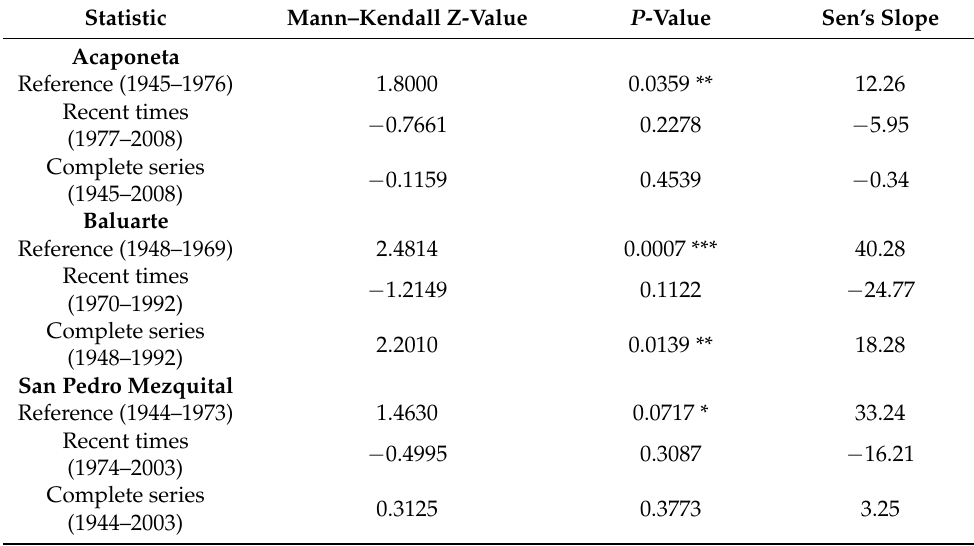
Table A2. The Mann–Kendall trend test and Sen’s slope of the mean annual runoff based on the periods of observation of the Acaponeta, Baluarte, and San Pedro Mezquital rivers. P -values are displayed at no significance ( p > 0.10), slight significative ( p < 0.10 *), significative ( p < 0.05 **), or strongly/very significative ( p < 0.01 ***) levels. Tests were computed in Minitab 18.